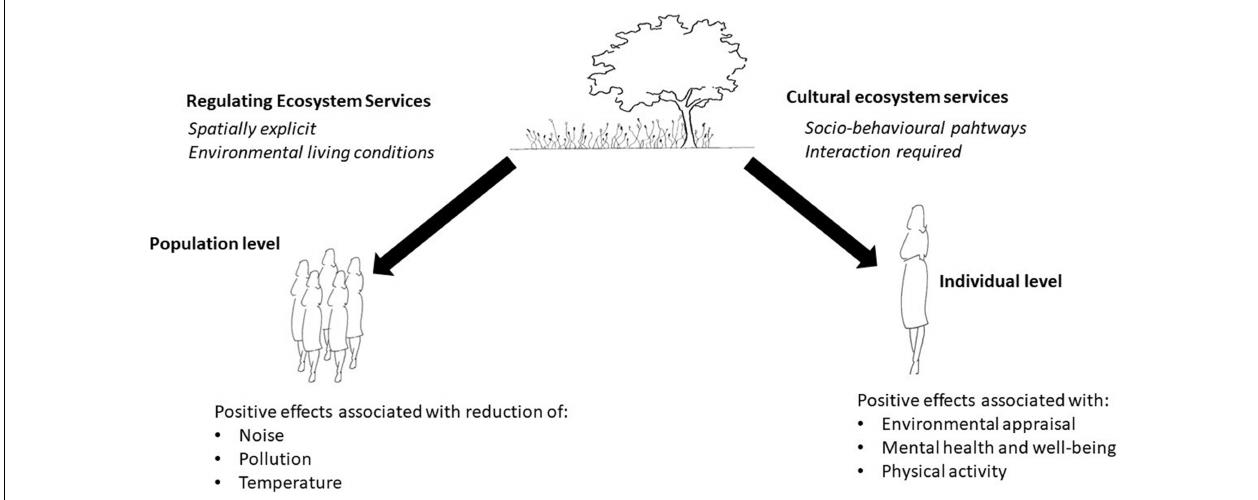
FIGURE 1 | Positive health benefits from urban green spaces, which are mainly associated with regulating and cultural ecosystem services. Regulating ecosystem services are spatially explicit and work on population level through improving environmental living conditions, while cultural ecosystem services are dependent on socio-behavioral pathways requiring interactions on individual